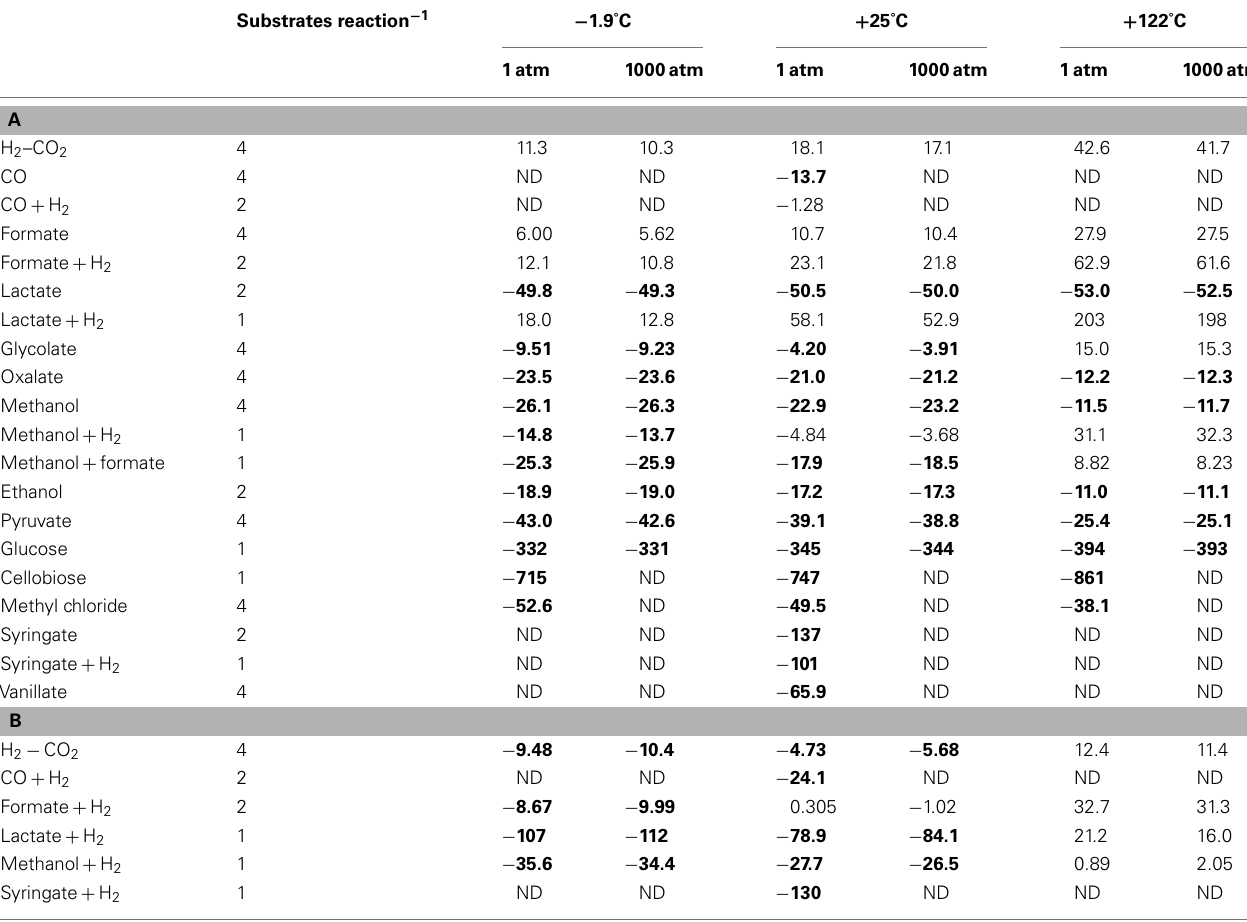
Table 4 | Gibbs free energy yields per substrate for the various acetogenesis reactions at a wide range of temperatures (˚C), pressures (atm), and H 2